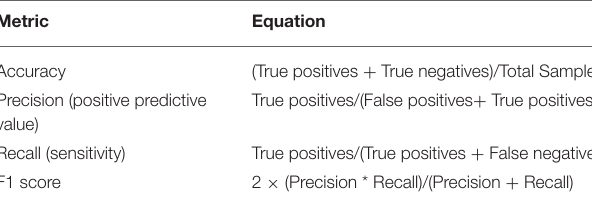
TABLE 2 | Predictive metrics and corresponding